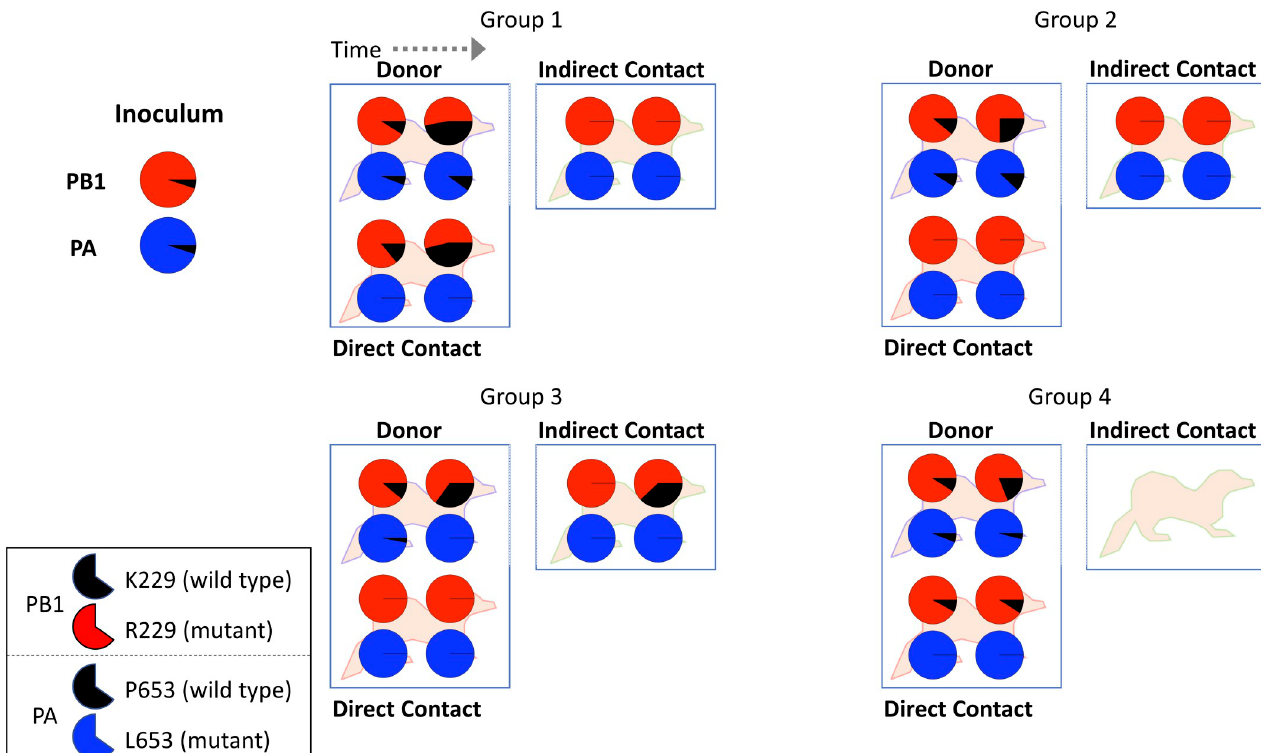
Fig 2. Targeted sequencing of PA and PB1 using NGS showed the percentage of PB1 K229R and PA P653L mutations for donor, contact and indirect contact ferrets. The top pie chart shows the percentage of each genotype for residue 229 in PB1 with the mutant (R229) in red and the wild type (K229) in black. The bottom pie chart shows the percentage of each genotype for residue 653 in PA with the mutant (L653) in blue and the wild type (P653) in black. The inoculum shows 5% K229 and 5% P653. For each infected ferret, two sequenced time points (as described in Fig 1) are shown. The group 4 indirect contact was not